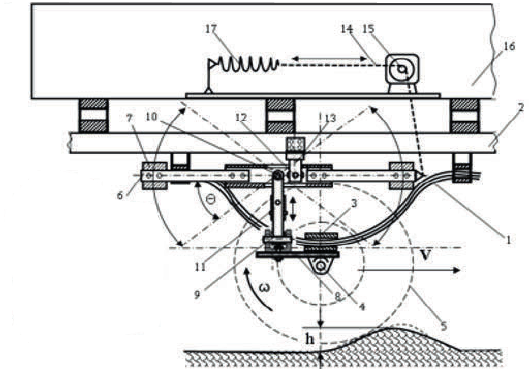
Fig. 3. The pendulum-type recuperative